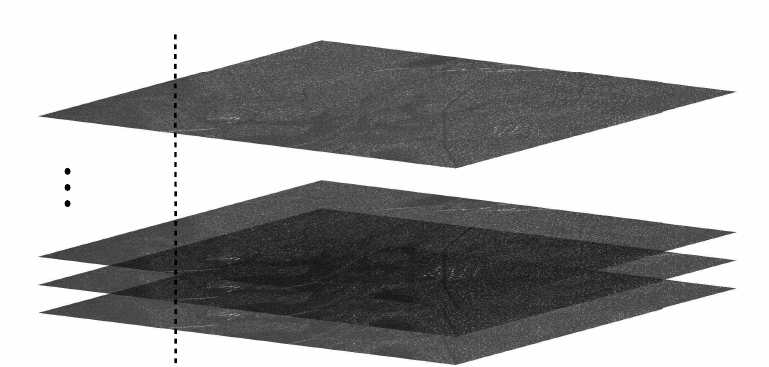
Figure 2. Stack of images to be considered in GSP. The methods should be applied for each pixel position, as evidenced by the vertical